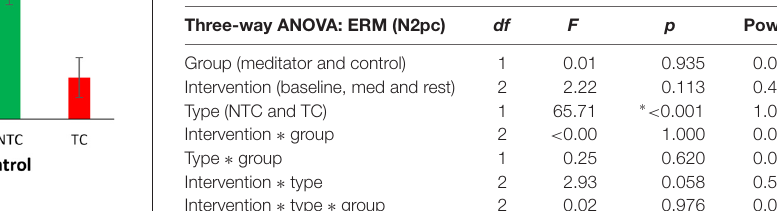
FIGURE 6 | The effects of the different distractor types for the two groups. The accuracy in the target-colored distractor condition (TC) was significantly lower than in the distractor absent (Absent) and non-target color distractor (NTC) conditions. The control groups’ performance in the TC condition was significantly lower than that of the meditator group. The data is the combined data from the two experimental days. Error bars indicate 95% confidence intervals. The asterisks ( ∗ ) indicate statistically significant differences ( p < 0.05).